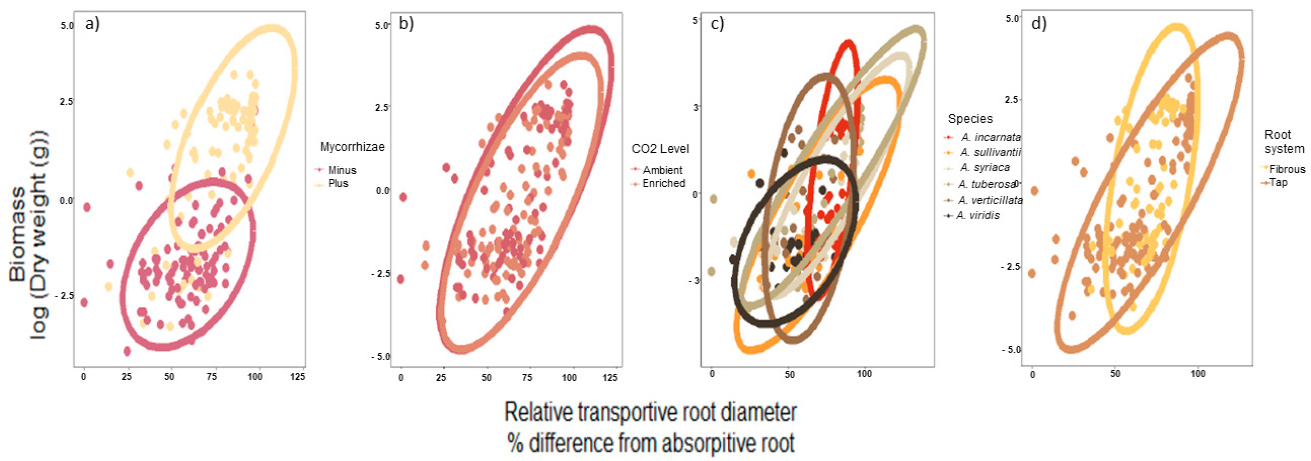
Figure 4. The relationship with biomass and relative transportive root across experimental factors. This relationship is decoupled by factor ( a ) mycorrhizae; ( b ) CO2 regime; ( c ) species; ( d ) root systems. Ellipses represent 95% CI for the levels in each of the factors described.